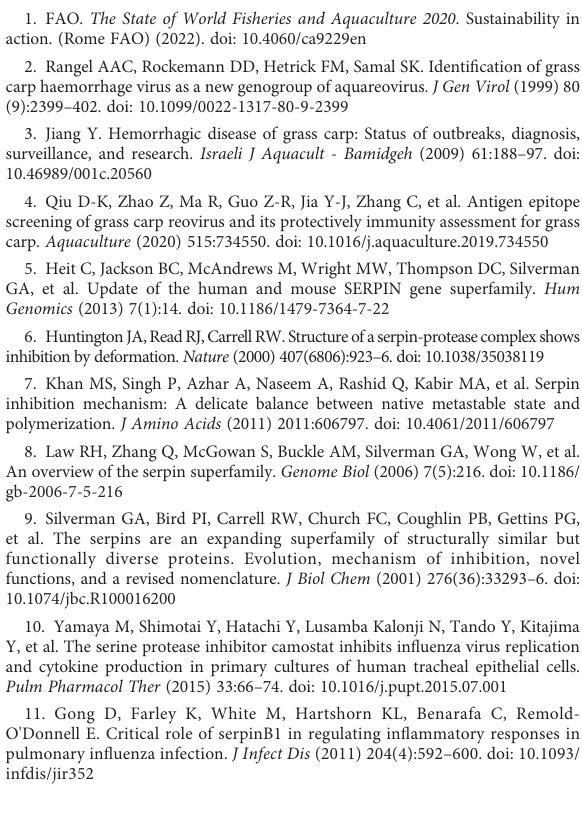
Validation of SERPINA1